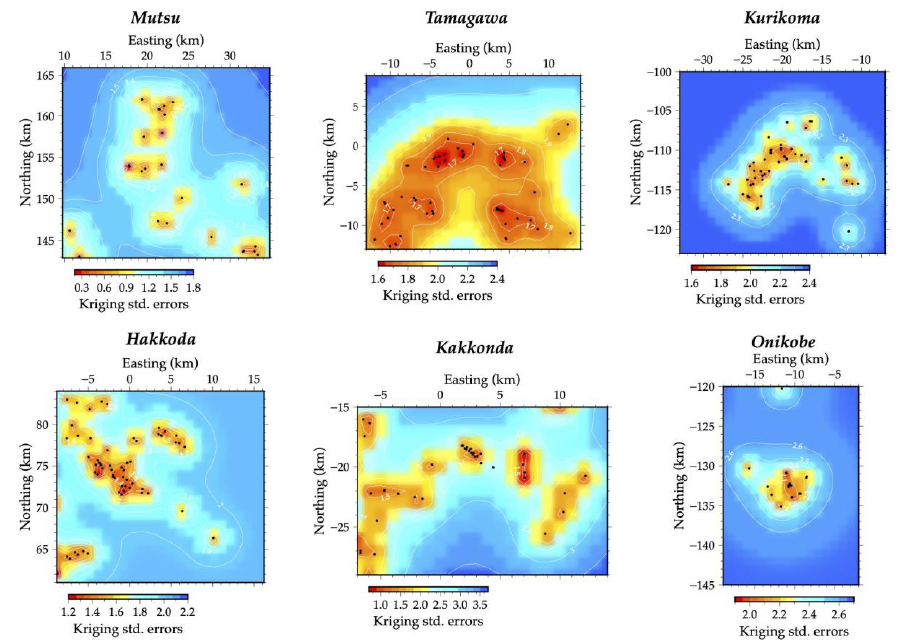
Figure 4. Kriging standard error of each study area. Black dots indicate data locations.